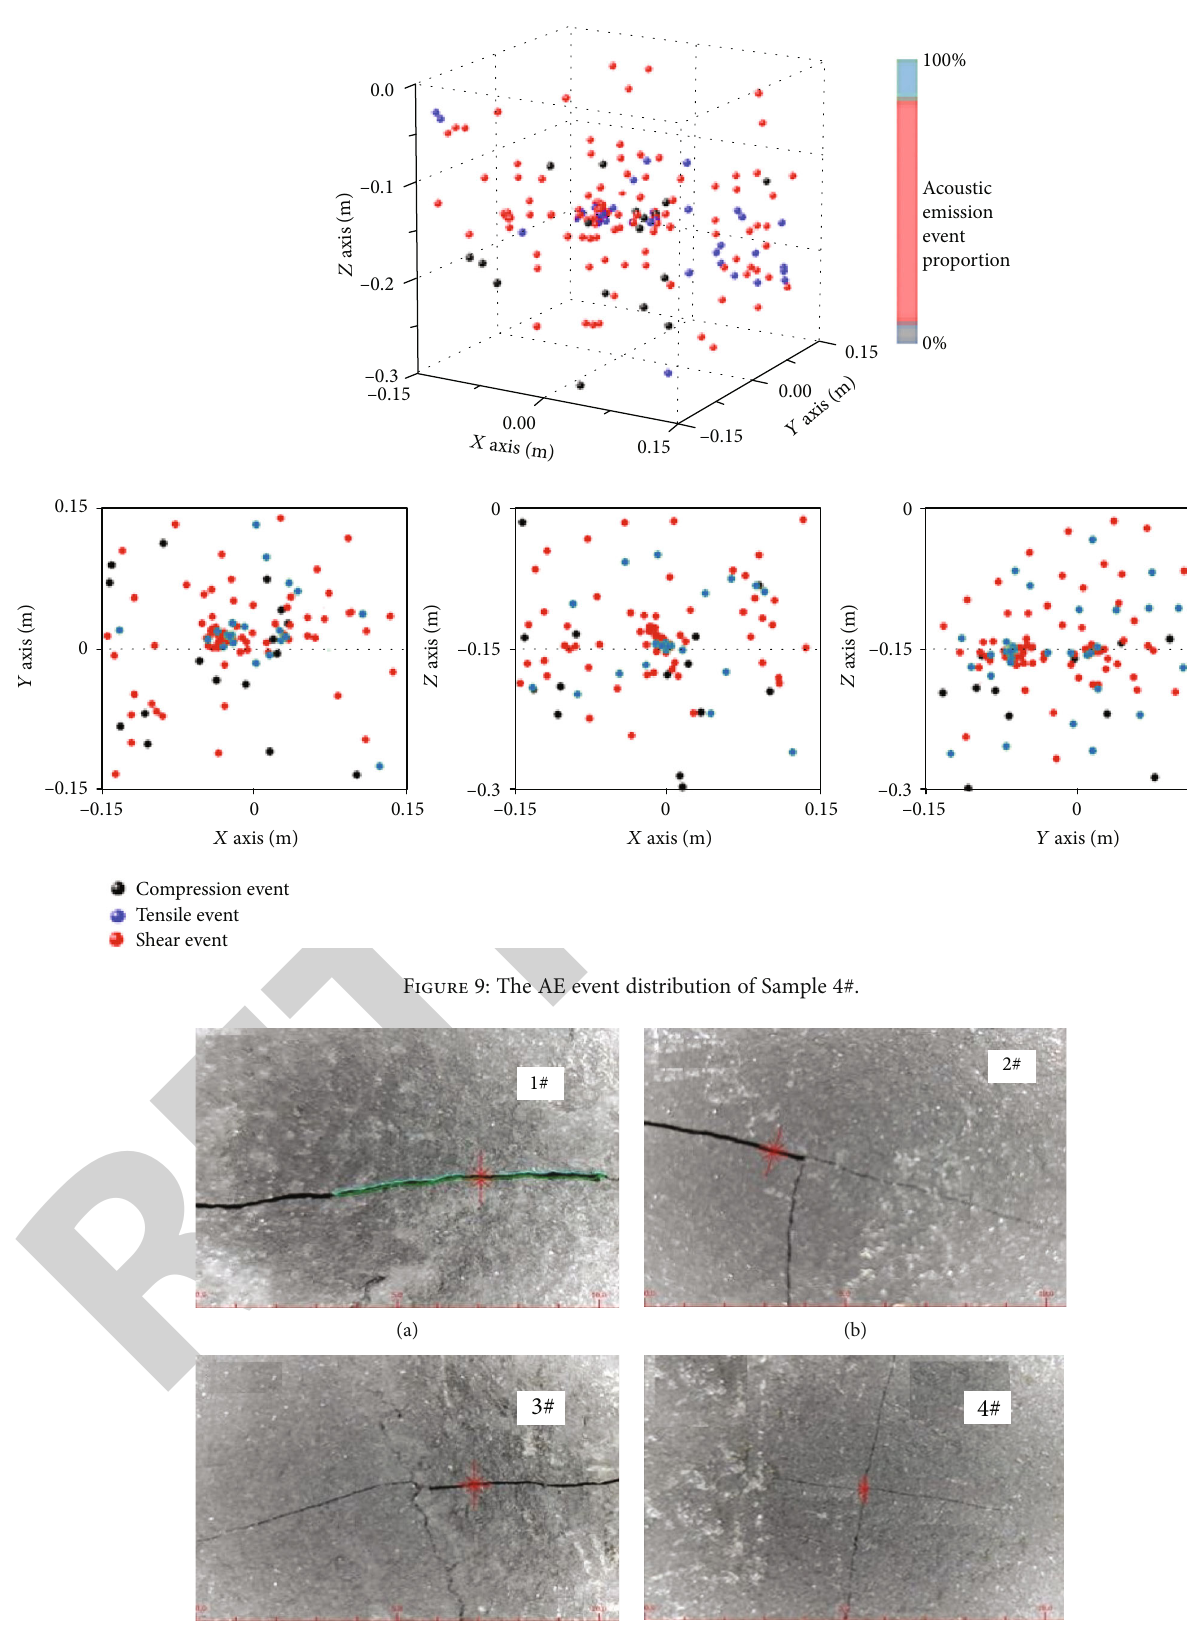
Figure 10: CT scanning images of hydraulic